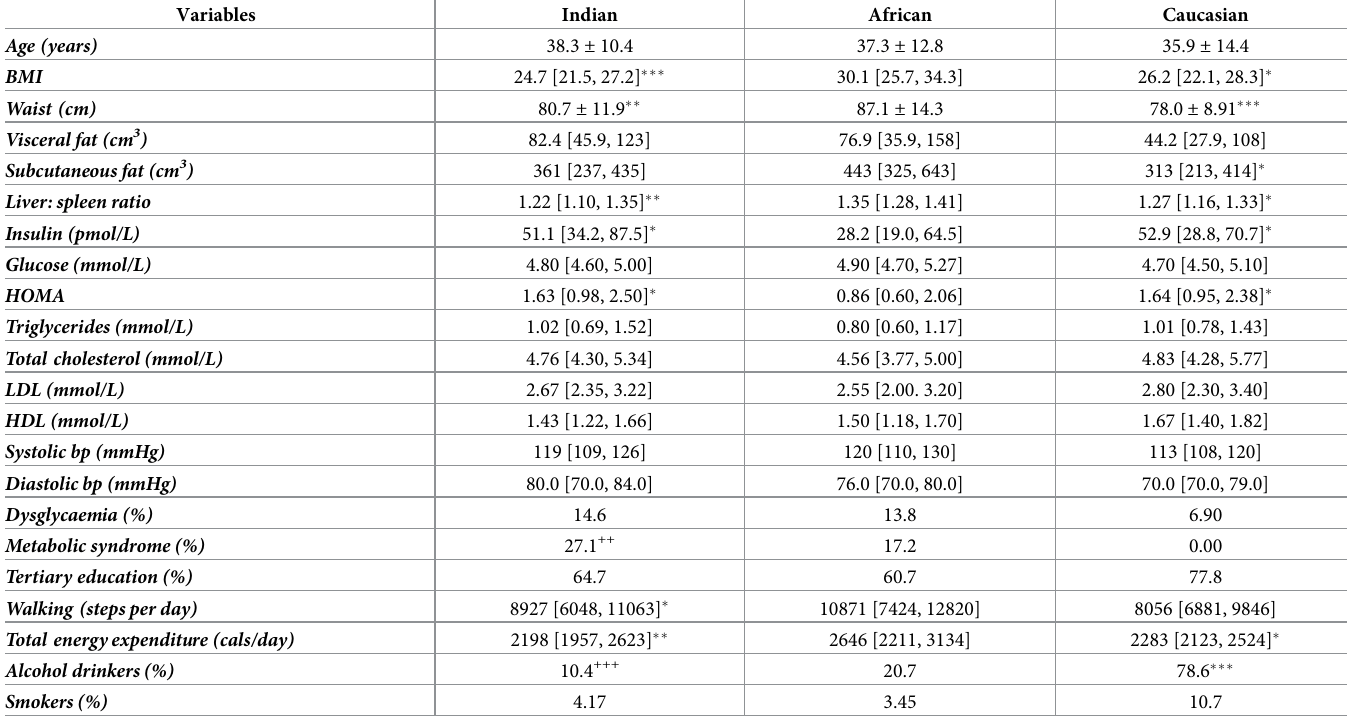
Table 1. Comparison of study variables between population